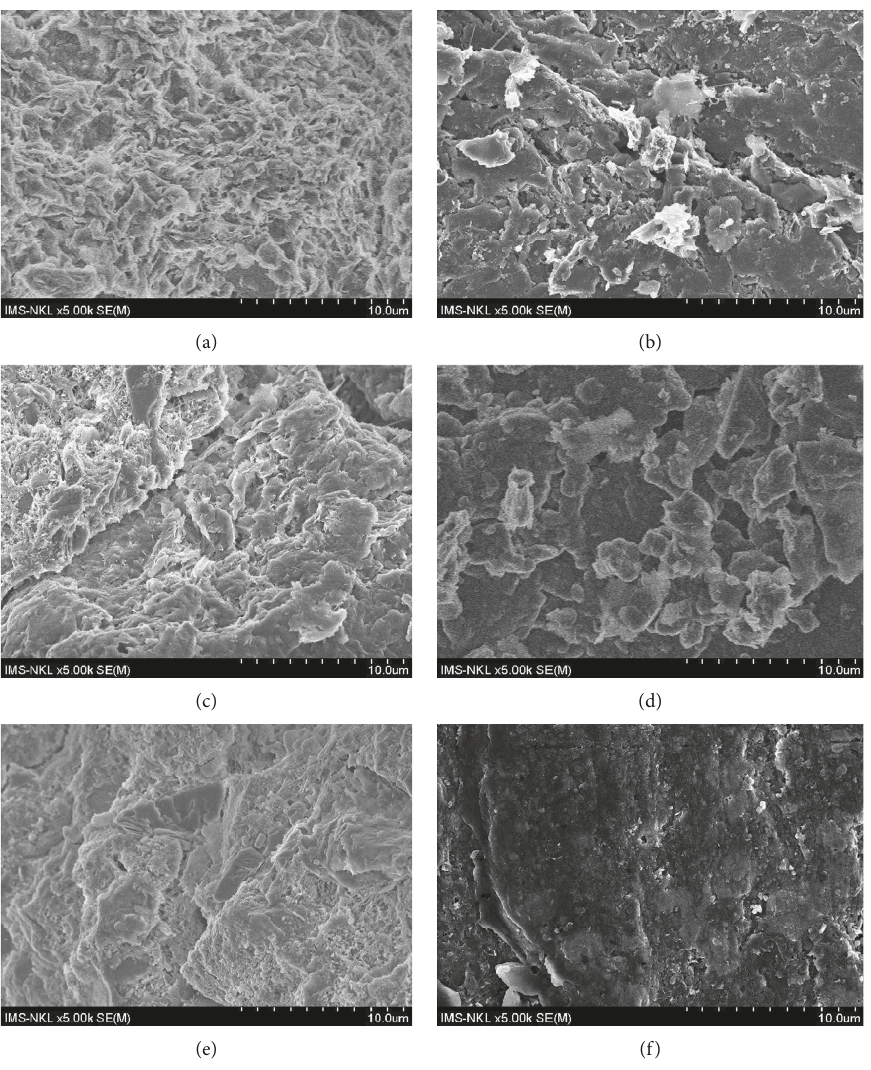
Figure 4: SEM images of composites before (left) and after (right) pyrolysis ( × 5,000): CNT/P (a, b), CNT-CF/P (c, d), and CNT-CF-G/P (e,